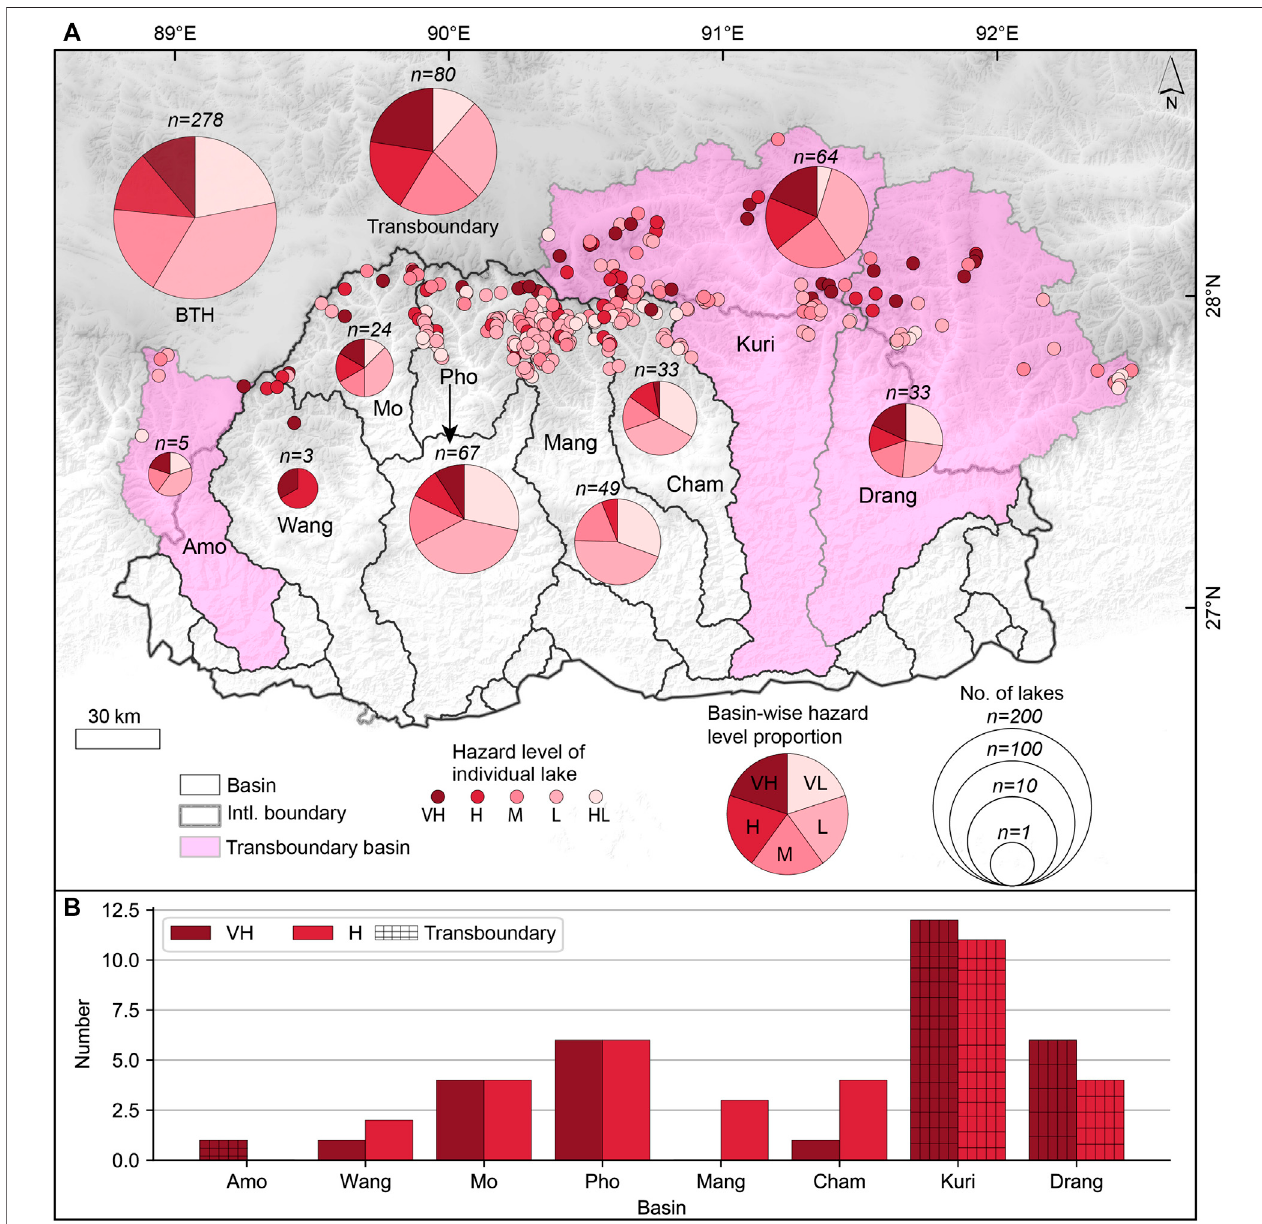
FIGURE8| Thepiechartsinthemap (A) showtheproportionalnumberoflakesofdifferenthazardlevels:veryhigh(VH),high(H),medium(M),low(L),andverylow (VL) across the different basins and in the BTH. The size of the pie chart indicates the total number (n) of lakes for which hazard assessments were carried out based on the initial two criteria (area (cid:2) 0.05 km 2 and glacier-lake distance (cid:2) 1,000 m). The bar chart (B) shows the distribution of high and very-high hazard-level glacial lakes across the eight basins and transboundary regions.